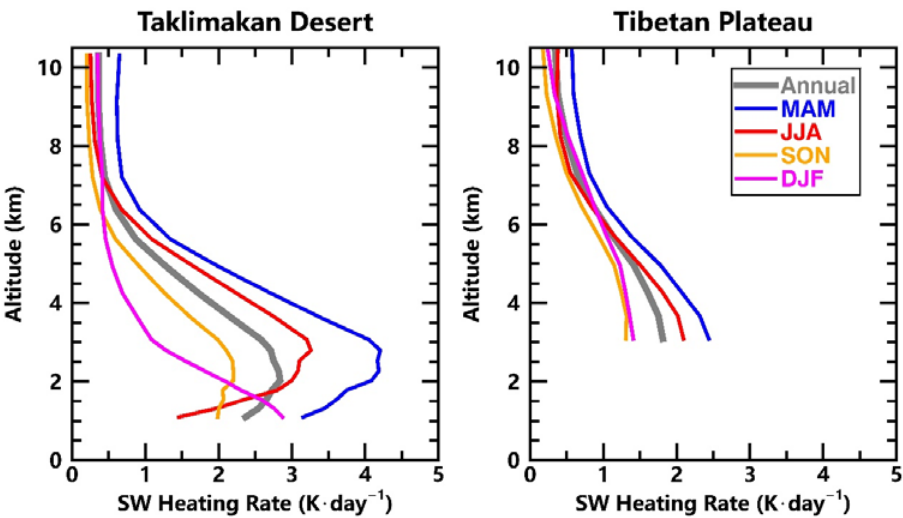
Figure 9. Annual and seasonal profiles of dust heating rate (DHR) in shortwave (SW) band simulated by SBDART over TD and TP.